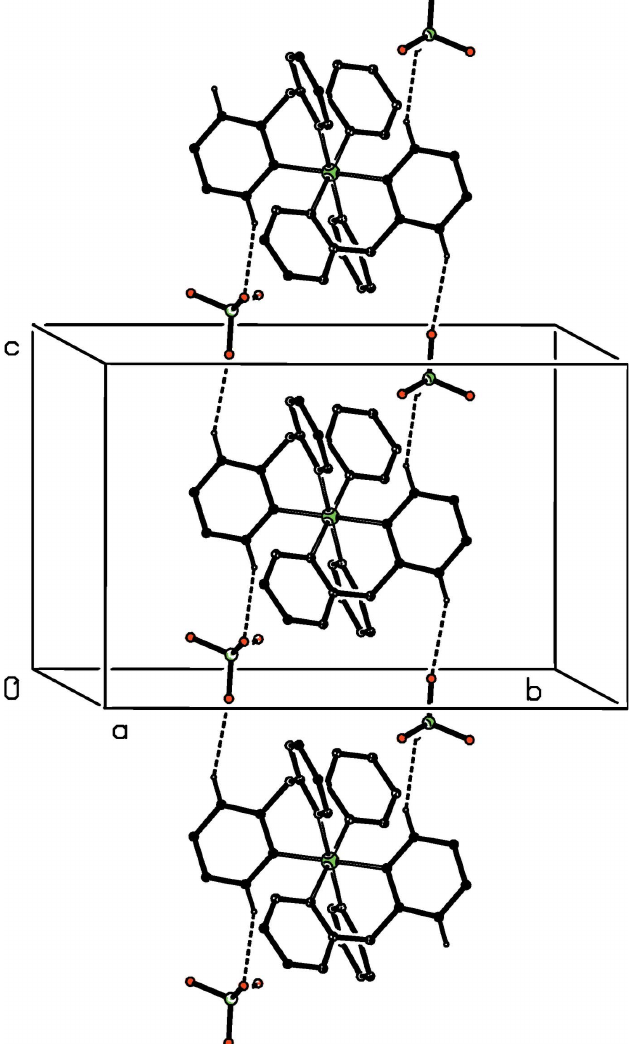
Figure 3 Part of the crystal structure of compound (I), showing the formation of a hydrogen-bonded ribbon running parallel to the [001] direction. For the sake of clarity, only the major disorder component of the anion is shown and the H atoms not involved in the motif shown have been omitted.